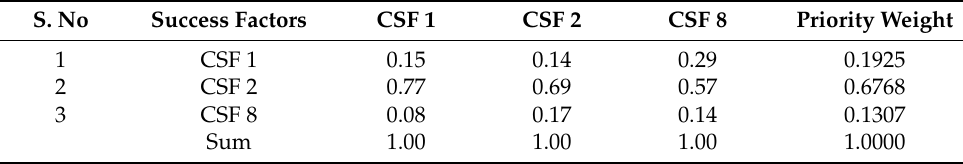
Table 17. Normalized matrix for preparation level success factors.